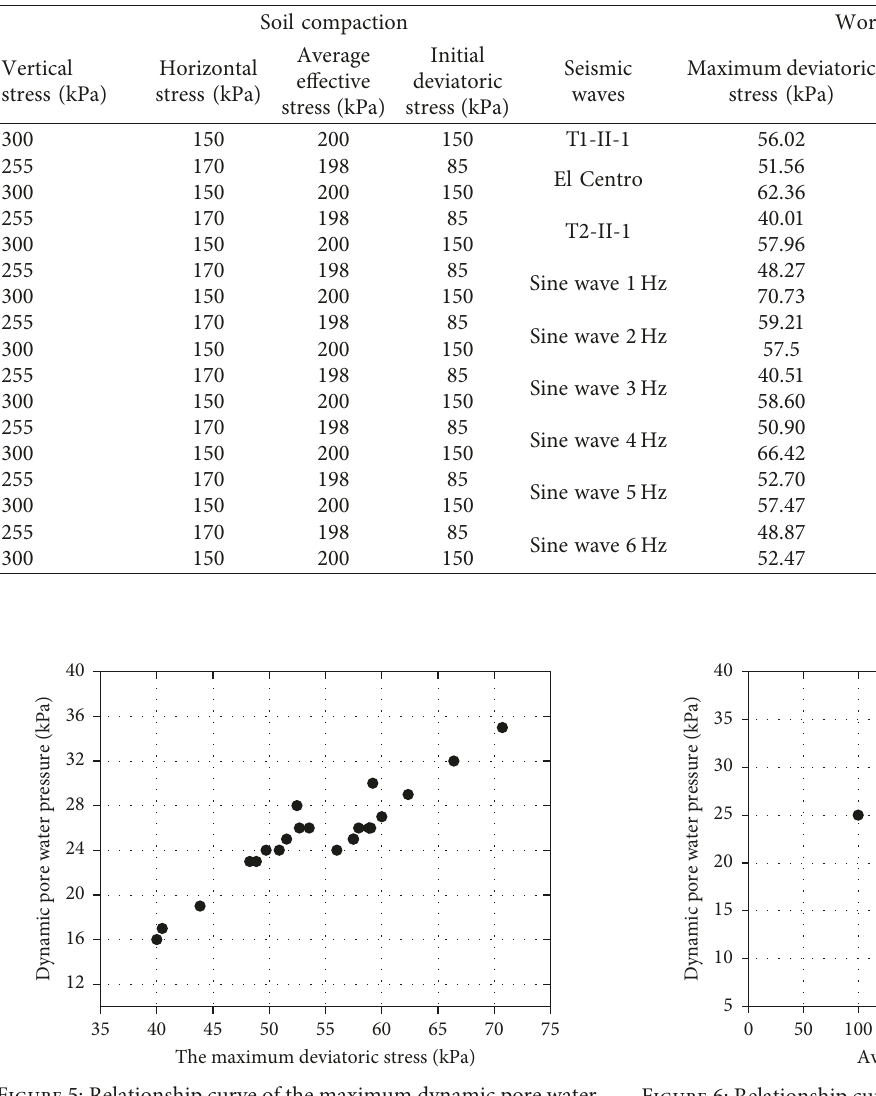
Figure 6: Relationship curve of the maximum dynamic pore water pressure and the average effective